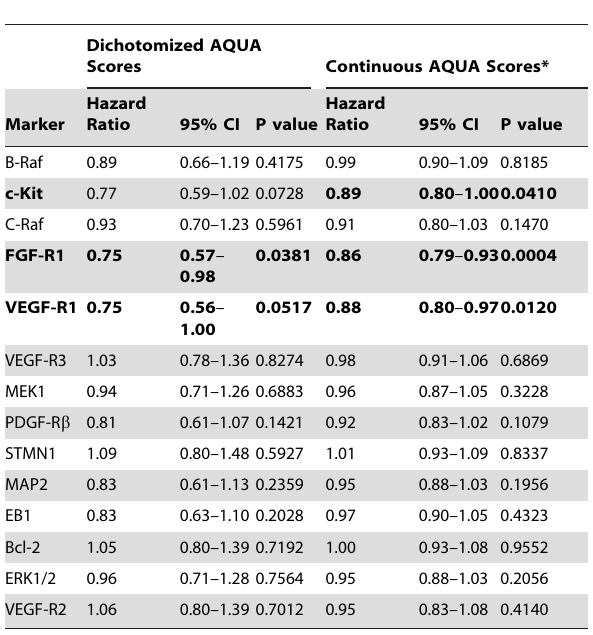
Table 4. Univariate Cox regression analysis of dichotomized and continuous AQUA scores for OS.